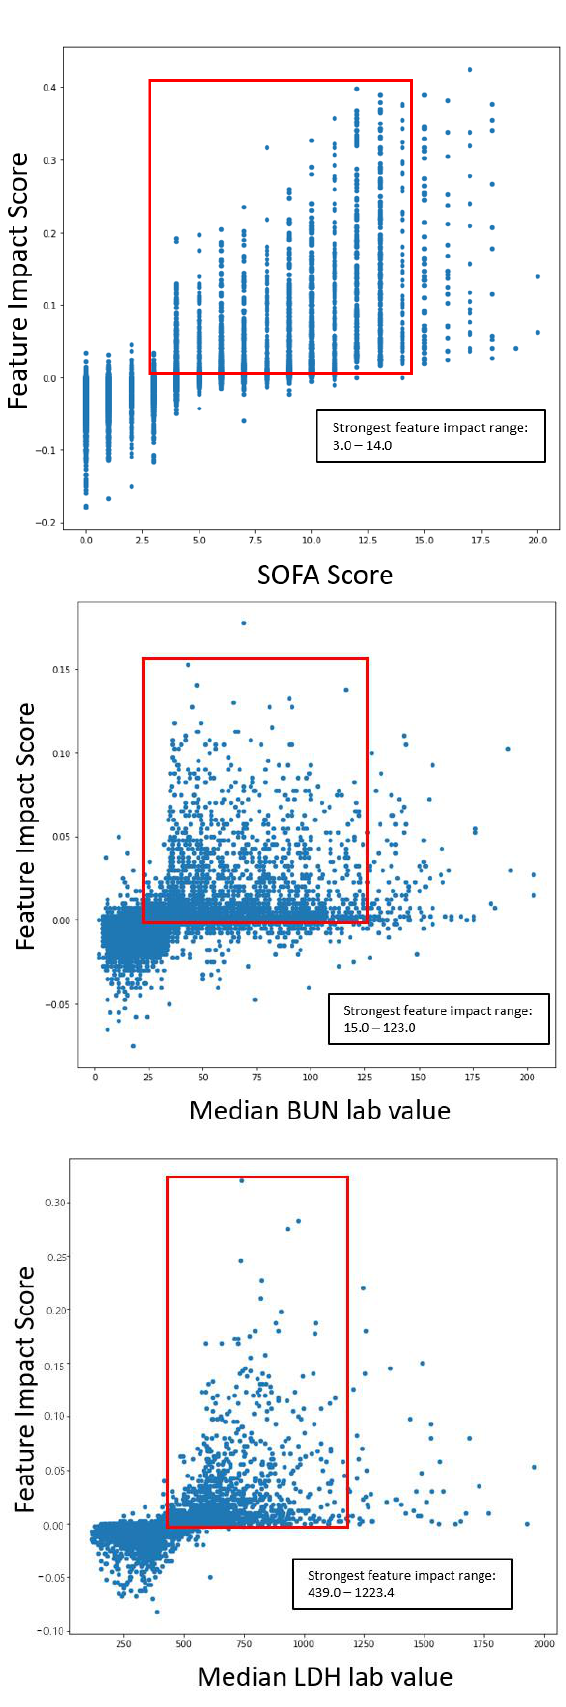
Figure 8. Range of impactful and validated biomarker values for COVID-19 severity prediction. The ranges of values were calculated by measuring the 5th and 95th quantile of bi- omarker values when the severity was high. The same logic was applied to survival mod- els. The following graphs in Figure 9 outline the specific range of values within scatter plots for impactful features concerning COVID-19 survival.